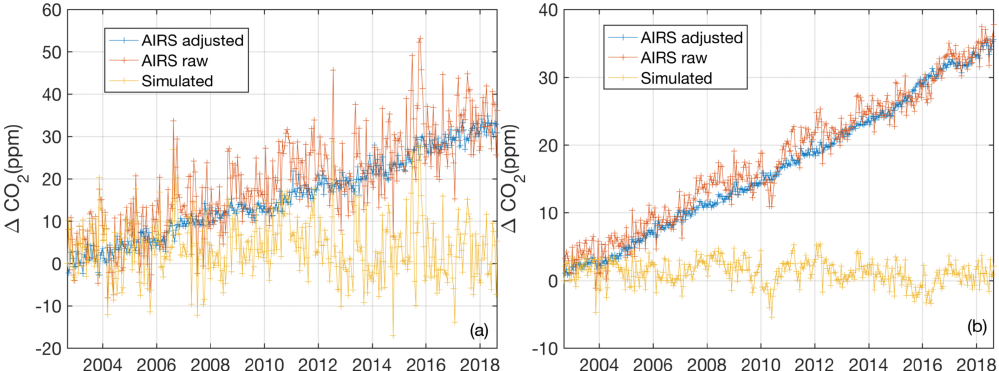
Figure 7. Illustration of “noise” removal in the CO 2 anomaly retrievals by subtracting the CO 2 retrieved from ERA-I simulations from the observed CO 2 retrievals: (a) − 55 ◦ latitude CO 2 retrieval; (b) ± 50 ◦ latitude average CO 2 retrieval.